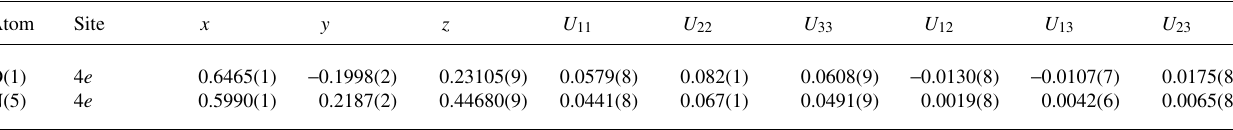
Table 3. Atomic coordinates and displacement parameters (in Å 2 )